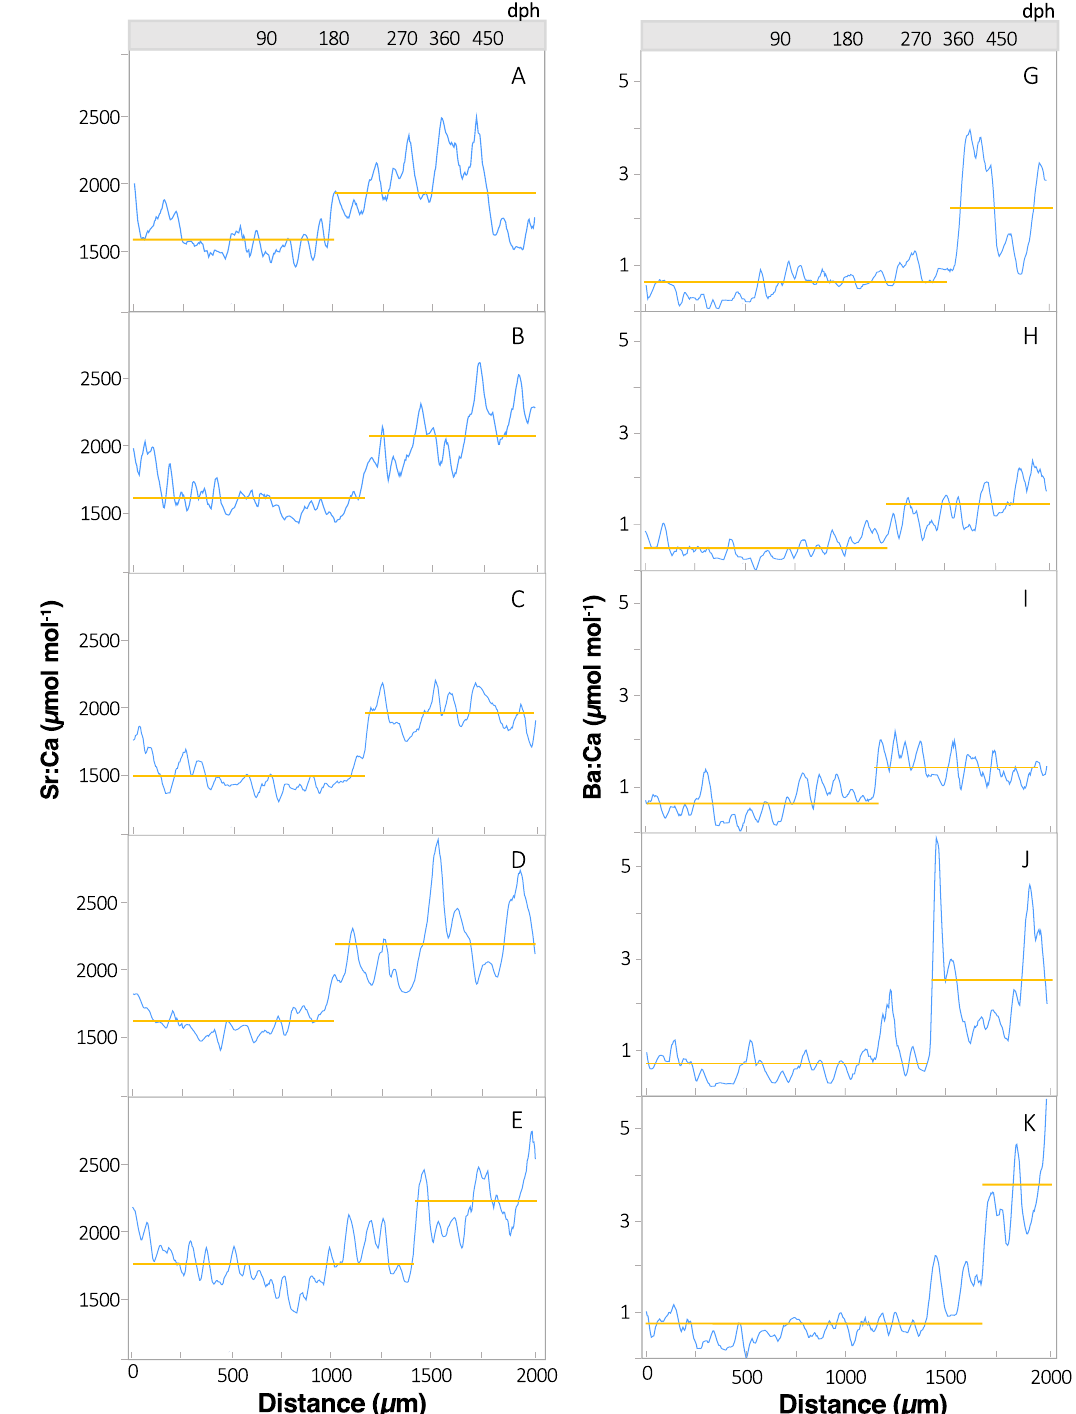
Figure 5. Otolith Sr:Ca (left, panels A – E )) and otolith Ba:Ca (right, panels G – K ) profiles for five individual Pacific bluefin tuna. Identification numbers from top to bottom: 103 ( A , G ), 210 ( B , H ), 221 ( C , I ), 271 ( D , J ), 463 ( E , K ); Table S2. Blue lines represent 7-point moving average and the location of geochemical changepoints along the laser path from otolith core to 2000 µm are shown as breaks in the horizontal lines (gold). Estimates of age isolines corresponding to distance along the laser path are also